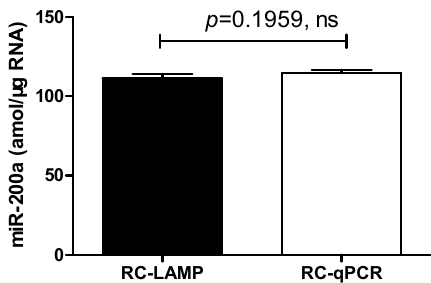
Figure 6. Comparison with RC-LAMP method and RC-qPCR method applied to miR-200a detection in HT-29 cells. There was no significant difference between RC-LAMP and RC-qPCR method. Experimental conditions (RC-LAMP): padlock probe 20 pmol/L, T4 DNA ligase 70 U, FIP/BIP 800 nmol/L and amplification temperature 62 °C. Experimental conditions (RC-qPCR): padlock probe 20 pmol/L, T4 DNA ligase and Vent (exo-) DNA Polymerase 70 U and 0.2 U, forward and reverse primer 100 nmol/L and annealing temperature 56 °C, respectively.